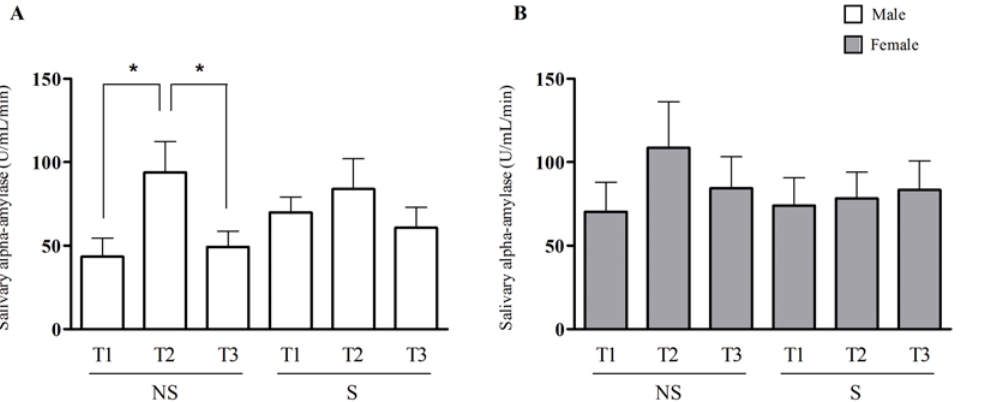
Fig 4. Salivary alpha-amylase activity during an acute mental stress test in non-stressed (NS) and stressed (S) subjects. A. Salivary alpha-amylase activity assessed prior to the Stroop test (T1), immediately after the Stroop test (T2) and five minutes after the test (T3) in non-stressed and stressed males subjects. B. Salivary alpha-amylase activity assessed at T1, T2 and T3 in non-stressed and stressed females subjects. ( * ) Indicates significant differences, p (cid:1) 0.05 (One-way ANOVA).